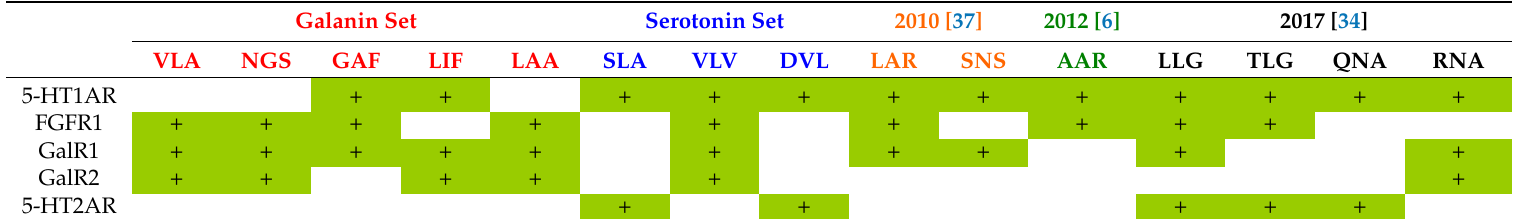
Table 1. Demonstration of protriplet amino acid homologies in 5-HT1AR–FGFR1, 5-HT1AR–5-HT2AR, and GalR1–GalR2